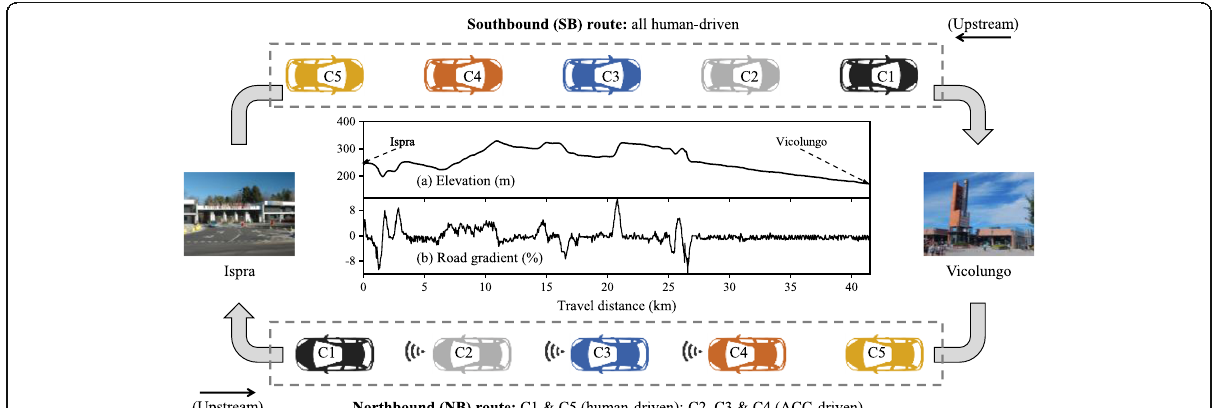
Fig. 2 The real-world driving experiment in highway multiple-car-following